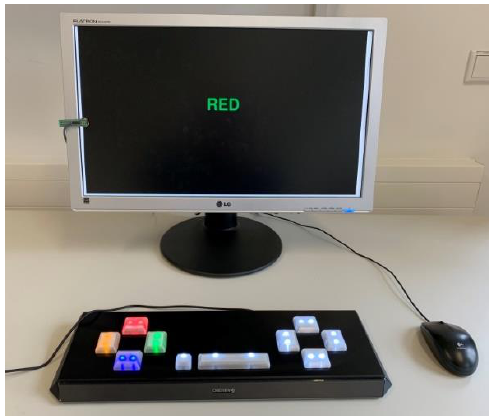
Figure 2. Measurement setup with the display, mouse pointer, and test